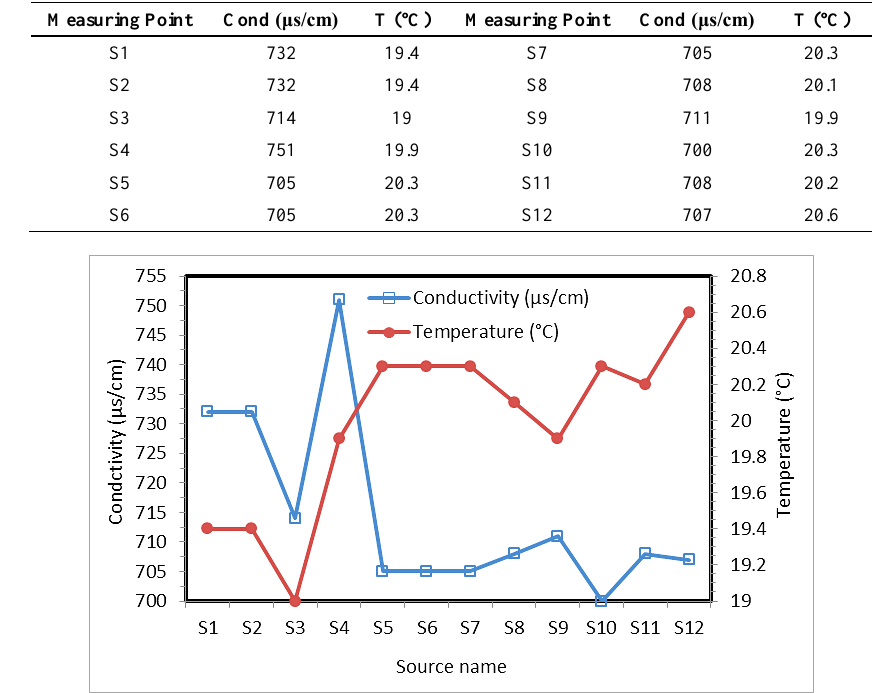
Figure 15. Fluctuation in conductivity and temperature at various resurgences located downstream from the dike of Hammam Grouz dam